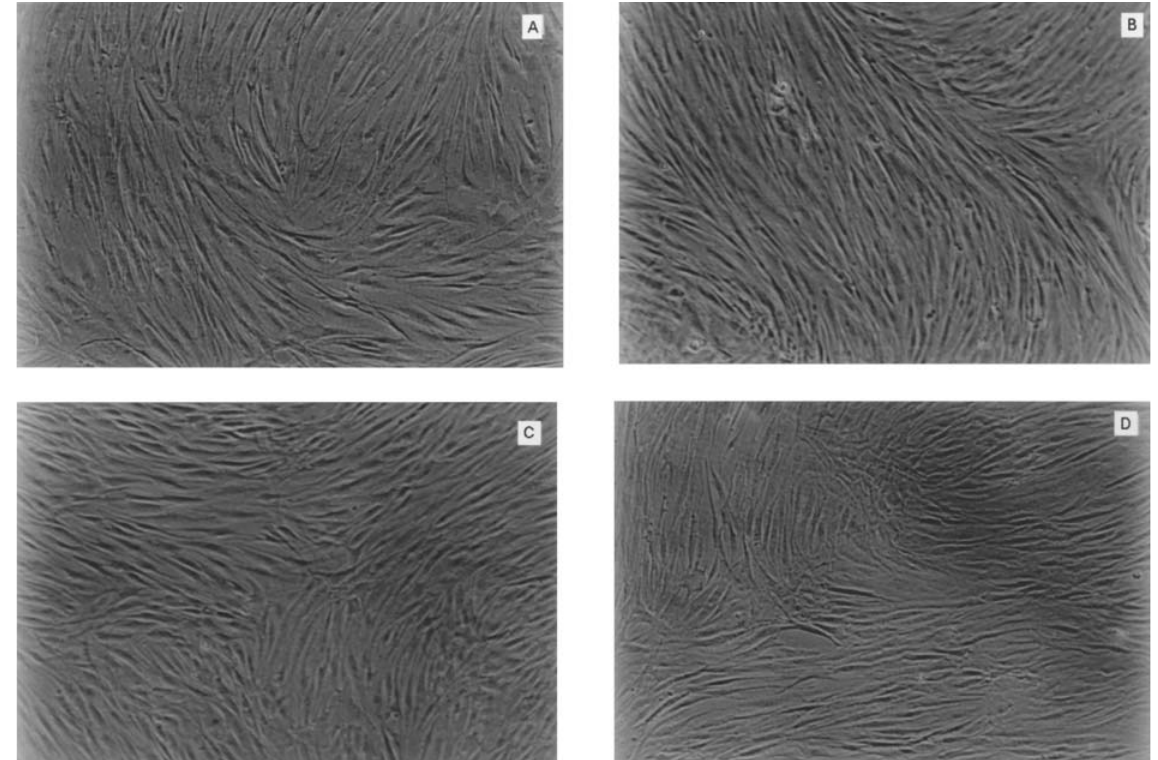
Figure 4 - Photograph of fibroblasts without (a) and after clindamycin 1 µ g/mL (b), 2 µ g/mL (c) and 3 µ g/mL (d) addition. (X 40).